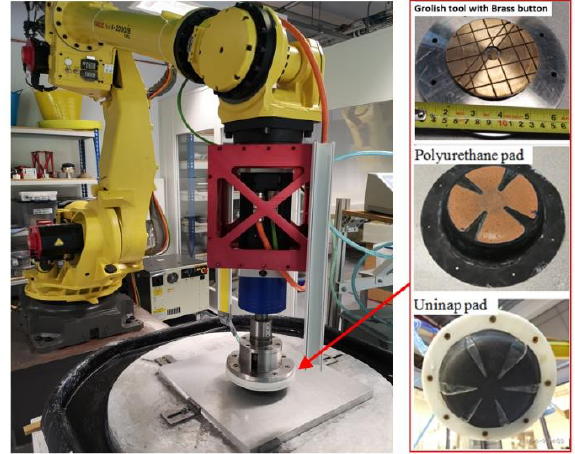
Fig. 3. Process development and optimisation.